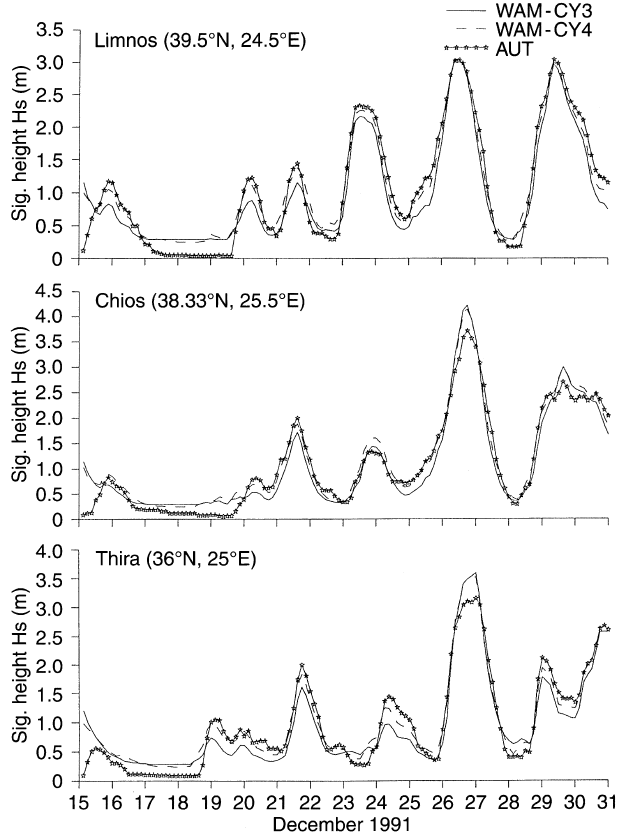
Fig. 11. Wave heights at specific grid points, December 1991 (WAM- cy3 v. WAM-cy4 v. AUT)